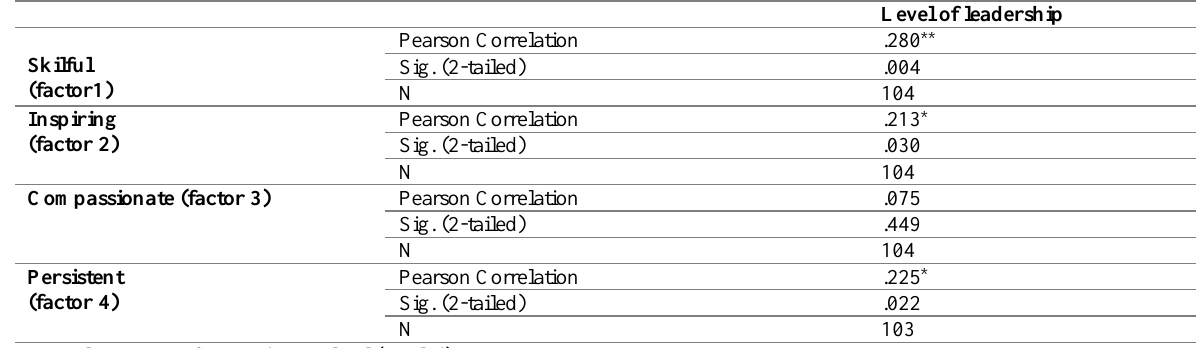
Table 6: Correlation